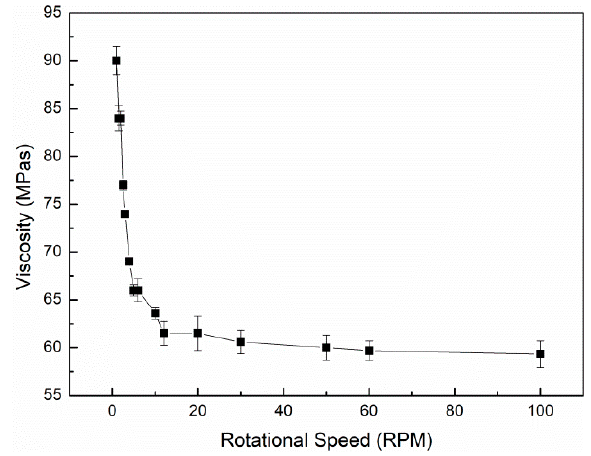
Figure 1. Relationship between the viscosity of the shell solution and the rotational speed at 20 °C . Shell solution: polylactic acid (PLA, 8%, w / v ) and fructooligosaccharides (FOS, 2.5%, w / v ) dissolved in the mixed solution of dichloromethane (DCM) and N,N - Dimethylformamide (DMF) (7:3, v / v ).